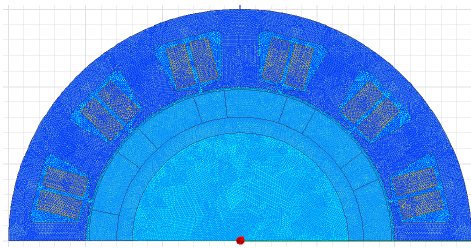
Figure 3. Simulation model of the FEA.